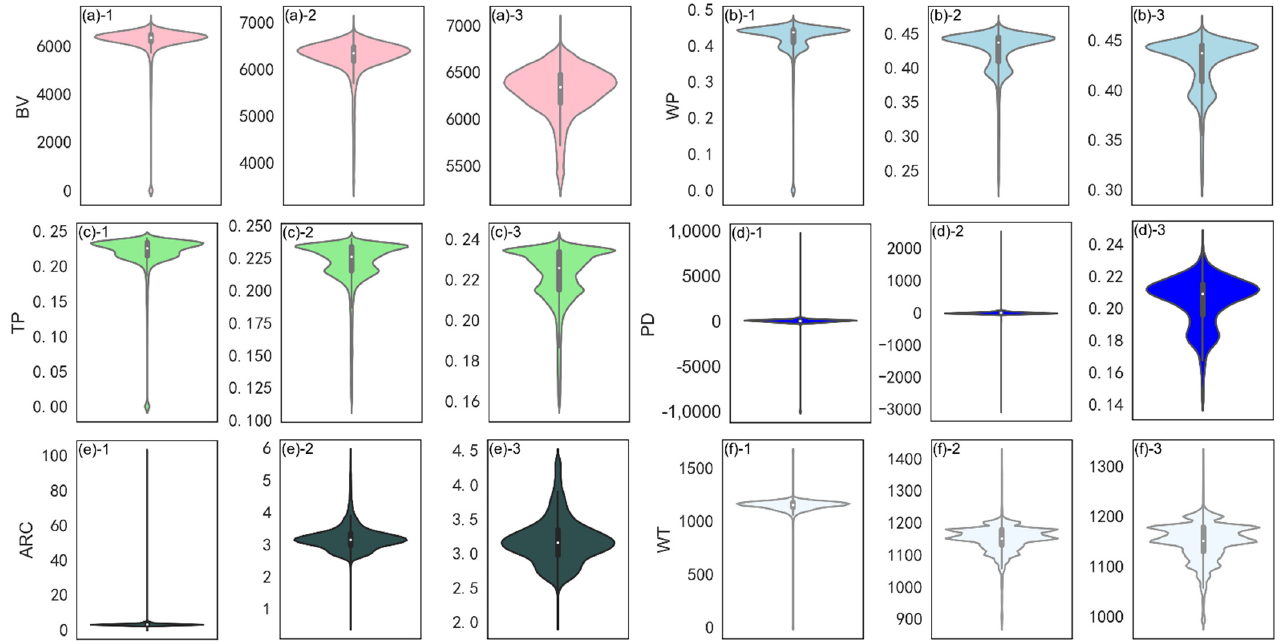
Figure 1. ( a – f ) Comparison of original data and processed data (1), i (i = 1, 2, 3) represents the data before a feature is processed, after it is processed by the box plot, and after it is processed by the 3 σ criterion, respectively.